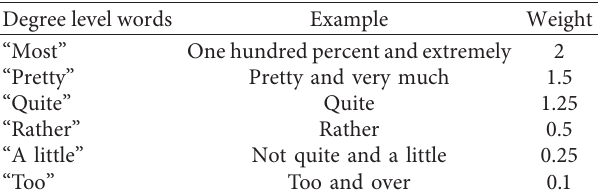
Table 4: Degree level word